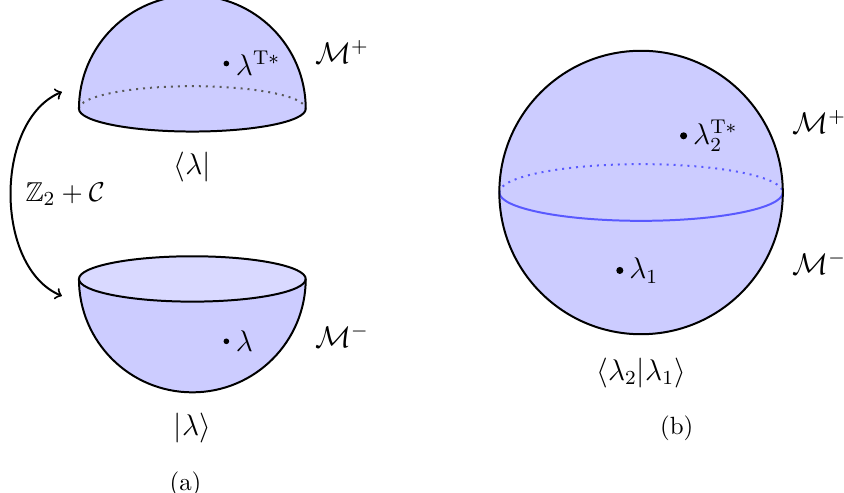
Figure 4. (a) The states j (cid:21) i we are considering are prepared by a Euclidean path integral. The function (cid:21) parametrises insertions of operators in this path integral. The dual states h (cid:21) j are prepared by doing the same path integral, but with everything acted upon by Z 2 + C , where Z 2 is Euclidean time re(cid:13)ection and C is complex conjugation. (b) The inner product of two such states is computed by doing a path integral on the manifold obtained by gluing together the two constituent manifolds along their boundaries. At large N , this manifold sets the boundary conditions for the bulk (cid:12)elds.